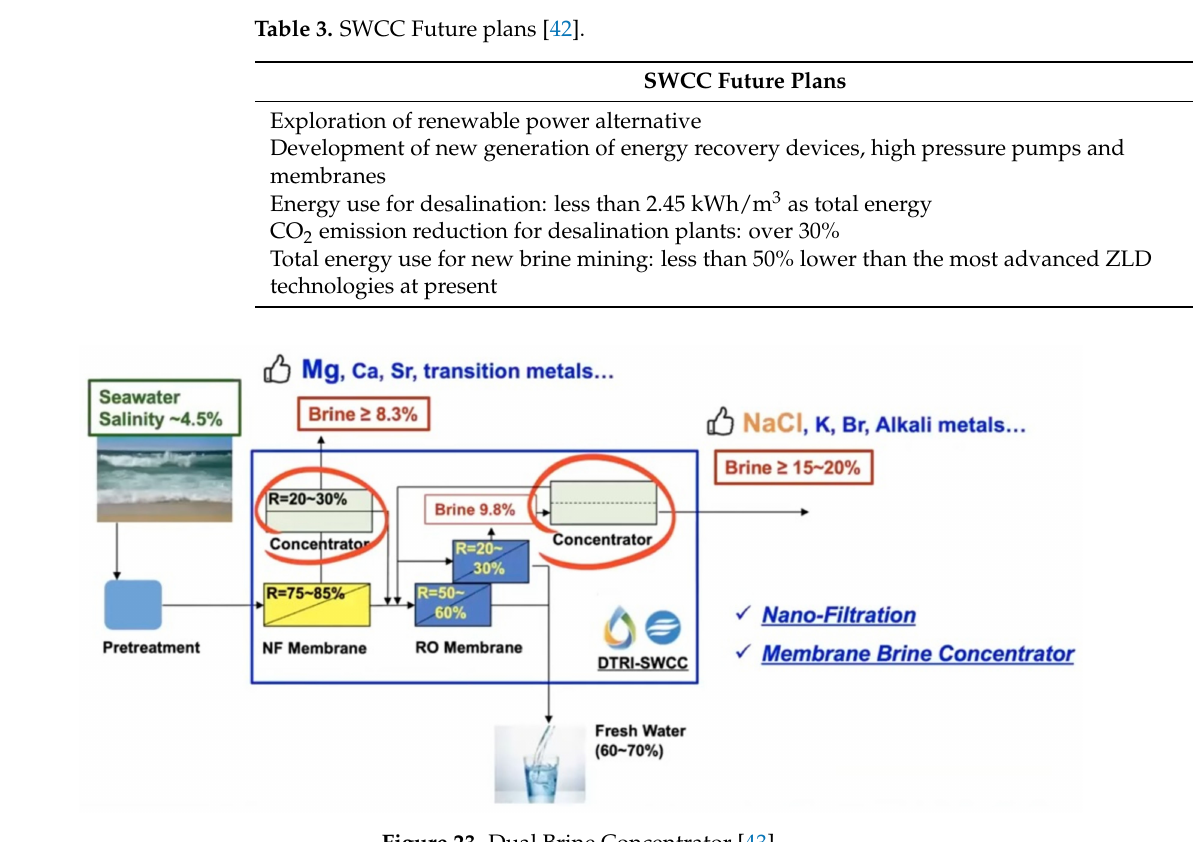
Figure 23. Dual Brine Concentrator [43].